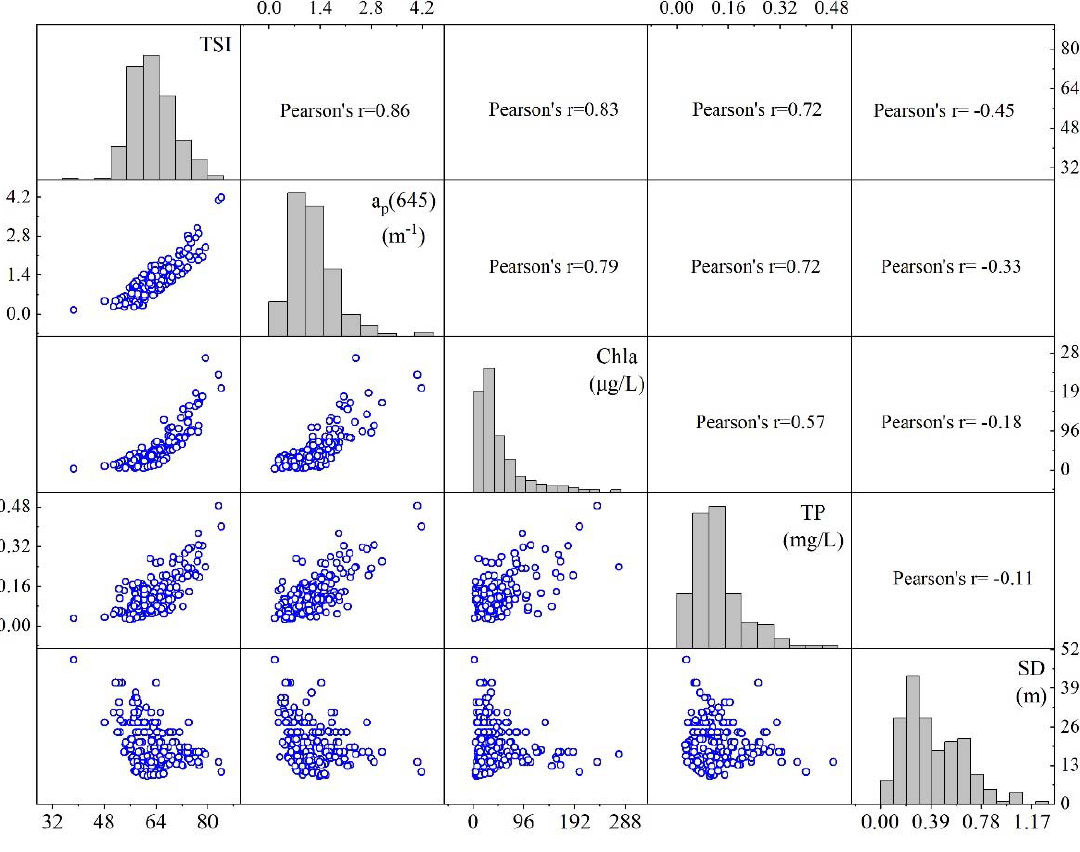
Figure 12. Matrix scatter of correlation analysis between TSI, a p (645), Chla, SD, and TP.